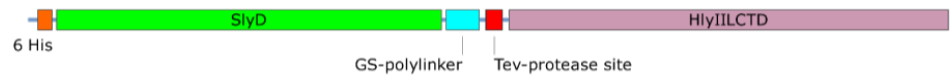
Figure 2. Scheme of the recombinant plasmid pTSL–HlyIILCTD. Thus, we succeeded in purifying the recombinant protein in a native water-soluble the